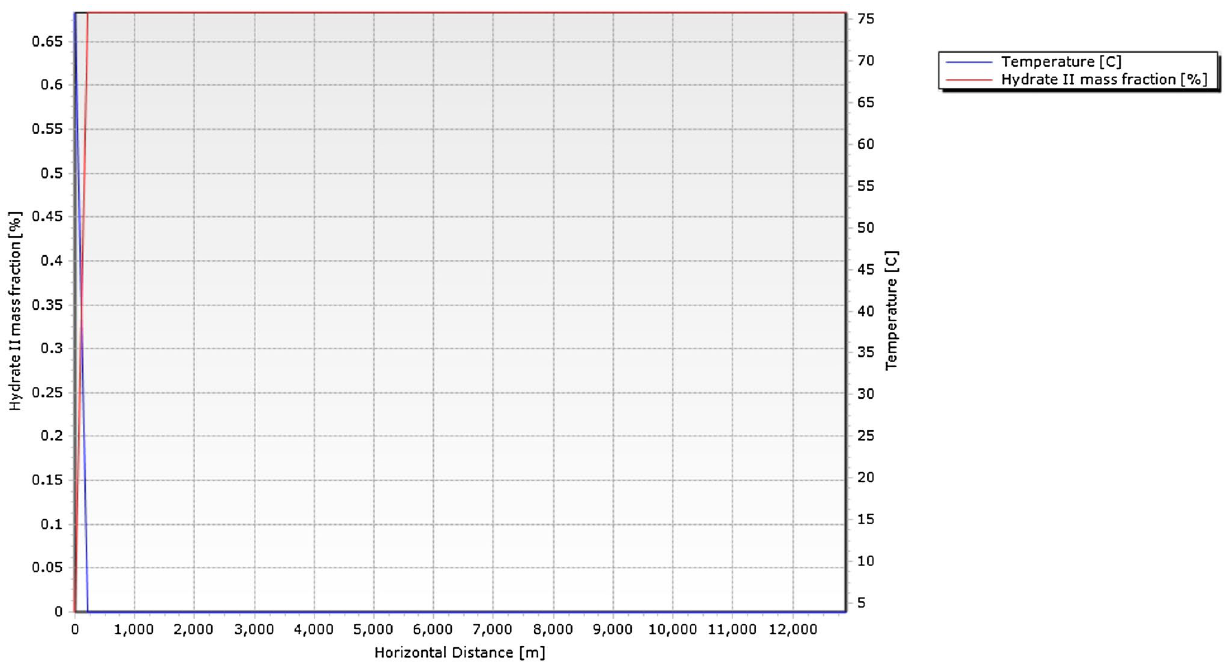
Fig. 10 Pipeline profile showing hydrate II mass